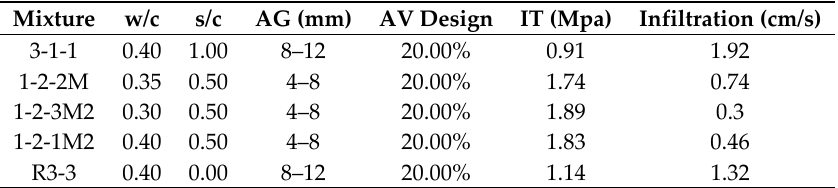
Table 3. Best five PC mixtures according to ANP